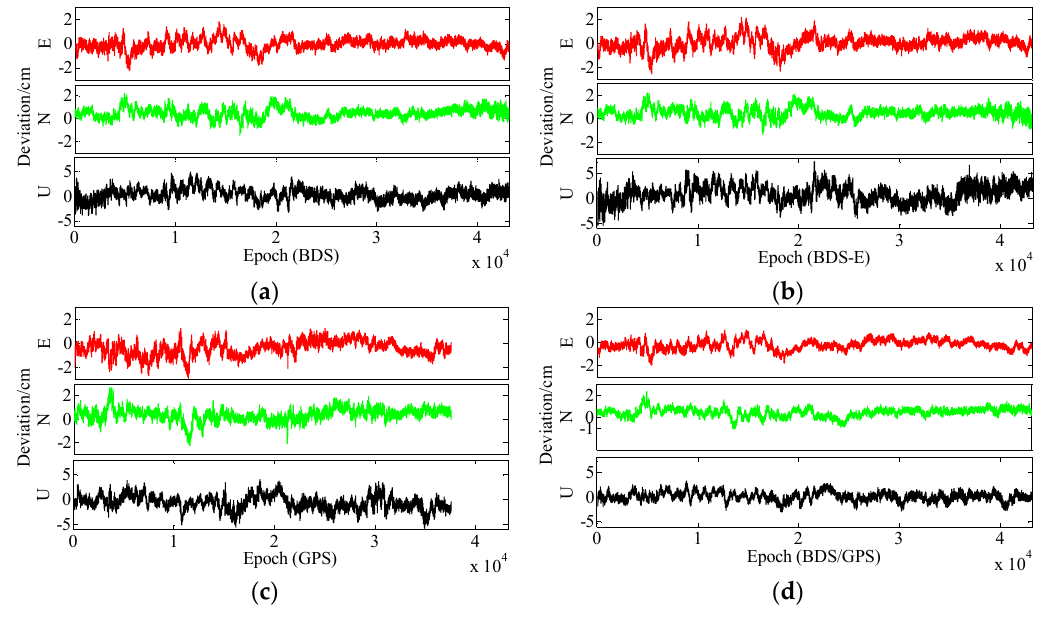
Figure 9. East (E), North (N) and Up (U) deviations of four systems for group A. ( a ) ENU deviations of BDS for group A. ( b ) ENU deviations of BDS-E for group A. ( c ) ENU deviations of GPS for group A. ( d ) ENU deviations of BDS/GPS for group A.